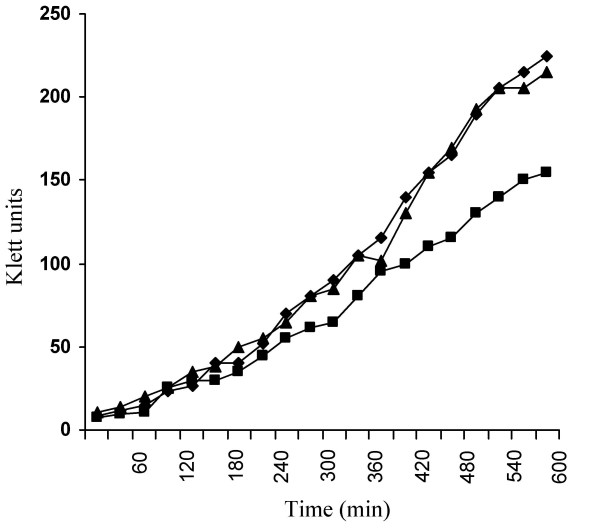
Effects of the ΔgcvB mutation on Y. pestis growth rates. Y. pestis strains KIM6 (◆), KIM6ΔgcvB (■), and KIM6ΔgcvB[pgcvBYp-sc] (▲) were grown in HIB (+ AP for the pgcvBYp-sc transformant) at 37°C. The experiment was repeated three times. The curves show the results of a representative experiment.